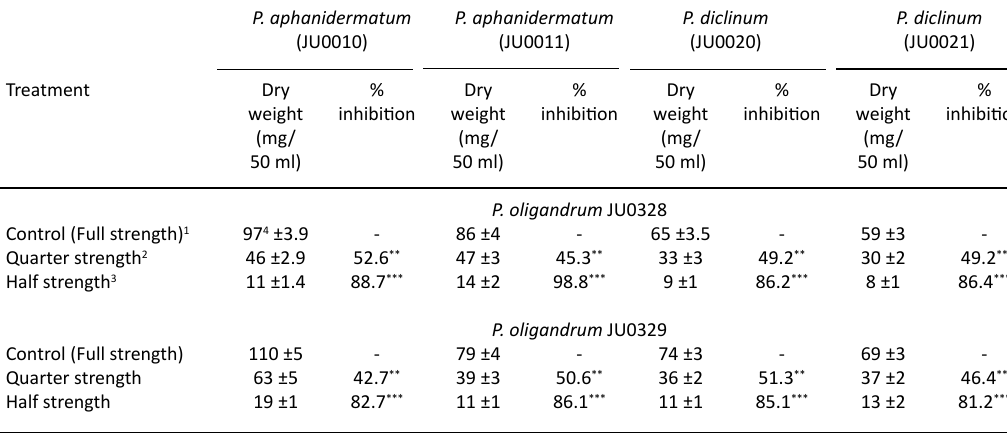
table 2. Effect of the inhibitory activity of different strength of cultural filtrate of two isolates of Pythium oligandrum on mycelial biomass growth of two isolates of each of Pythium aphanidermatum and Pythium diclinum grown on solid V-8 agar medium at 25°C in the dark